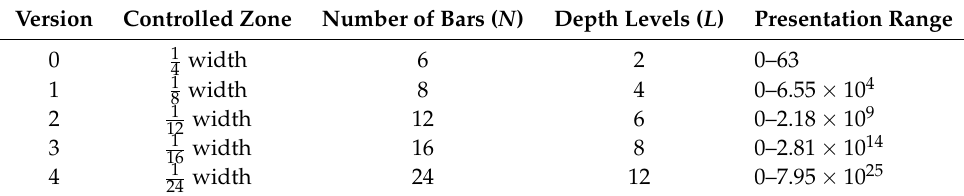
Table 2. Specification of different versions of multi-level